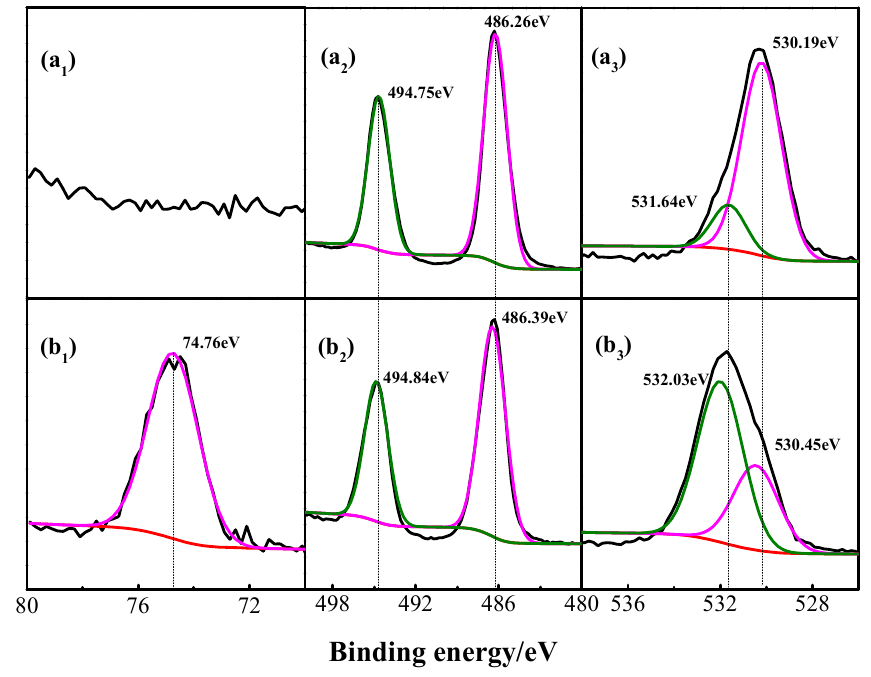
Figure 10. XPS spectra on the cassiterite surfaces: ( a 1 ) Al2p peaks of pure cassiterite; ( b 1 ) Al2p peaks of cassiterite treated with Al (III) ions; ( a 2 ) Sn3d peaks of pure cassiterite; ( b 2 ) Sn3d peaks of cassiterite treated with Al (III) ions; ( a 3 ) O1s peaks of pure cassiterite; ( b 3 ) O1s peaks of cassiterite treated with Al (III) ions.